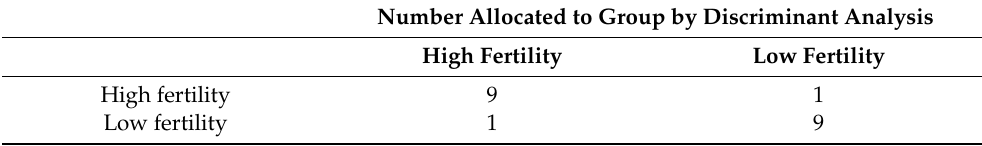
Table 3. Percentage of sperm samples assigned to each fertility group by discriminant analysis. Number Allocated to Group by Discriminant Analysis High Fertility Low Fertility High fertility 9 1 Low fertility 1 9 90.0% of the samples were classified